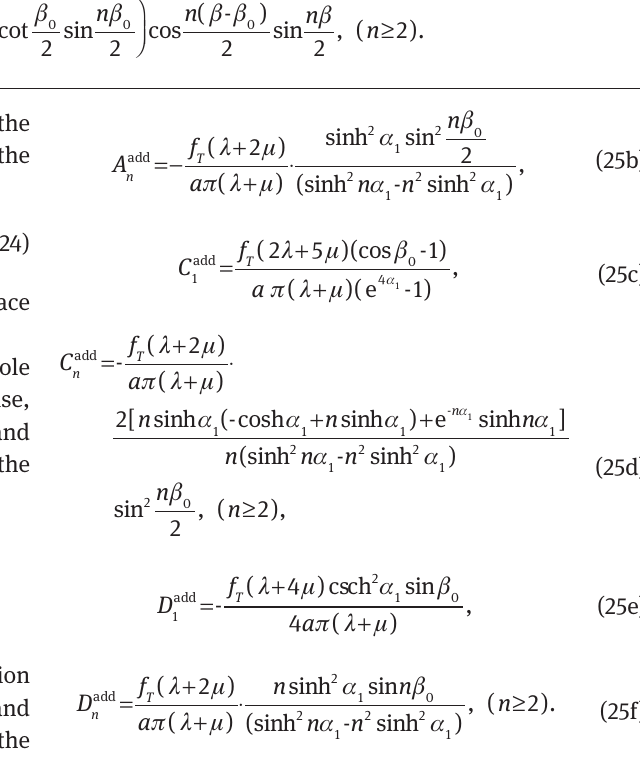
Figure 4 Contour maps of the normal normal force. Coordinate x is a coordinate of the measured displacement; x expressed in units of the radius of the hole ρ ; the displacements are presented in units of normal force; and λ , μ are the elastic modules. The distance between the center of the hole and the planar boundary is d = 1.54 ρ